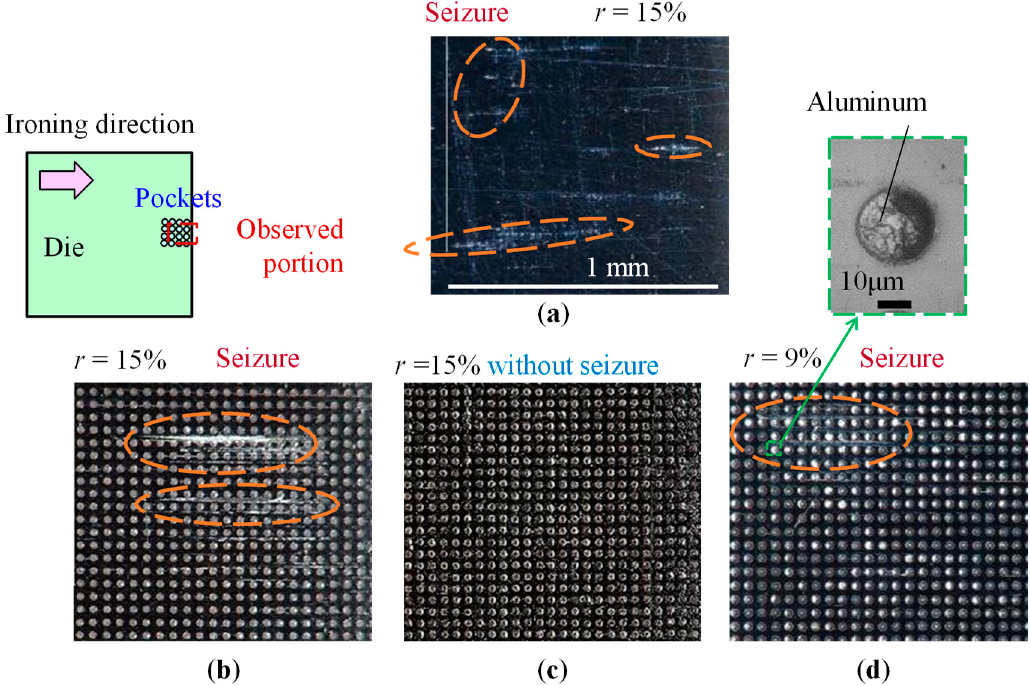
Figure 10. Occurrence of seizure on die with ( a ) smooth surface at r = 15% and with grid array pattern, d = 30 µ m, L = 50 µ m, pocket depth h of ( b ) 1 µ m at r = 15%, ( c ) 2 µ m at r = 15%, and ( d ) 6 µ m at r = 9%.